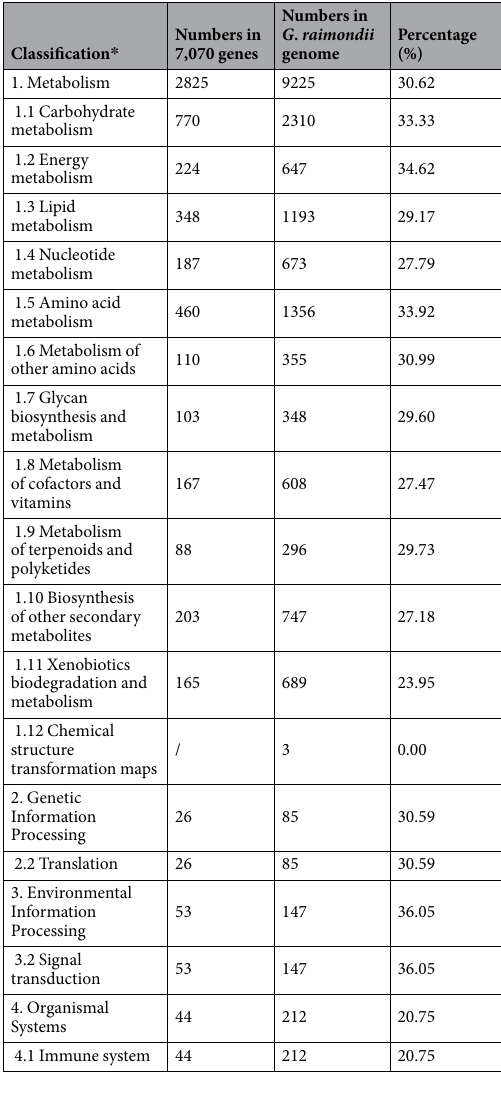
Table 2. KEGG classification of 7,070 orthologs and their percentage in the whole genome. * KEGG annotation and metabolism maps were performed with